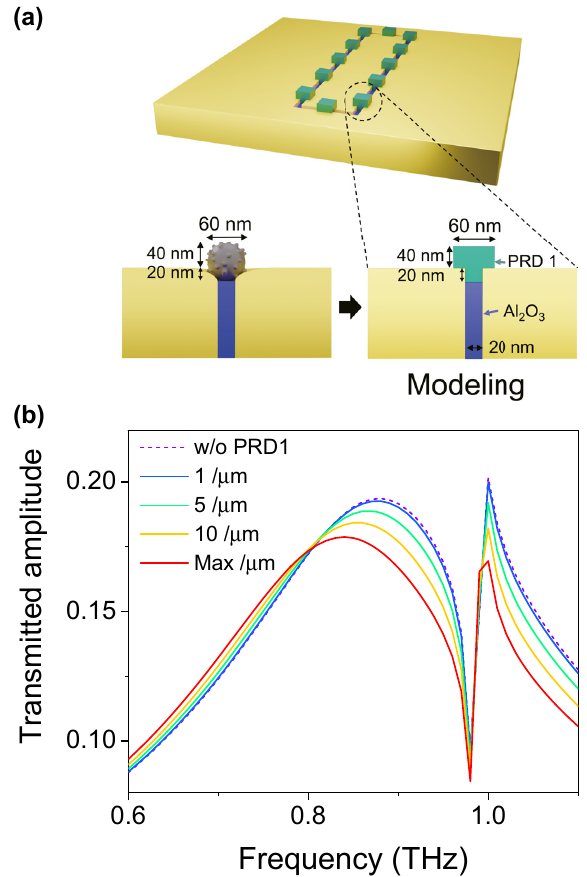
Figure 5: Full-wave numerical simulations. (a) Schematic illustrations of the simulation modeling. The spherical shape of the PRD1 virus has been changed to a T-shape in order to minimize the computing time of the simulation. (b) The transmission amplitude spectra of the 20 nm gap depending on their PRD1 virus densities. Here the density of the virus particle is defined by the number of viruses per unit length in the